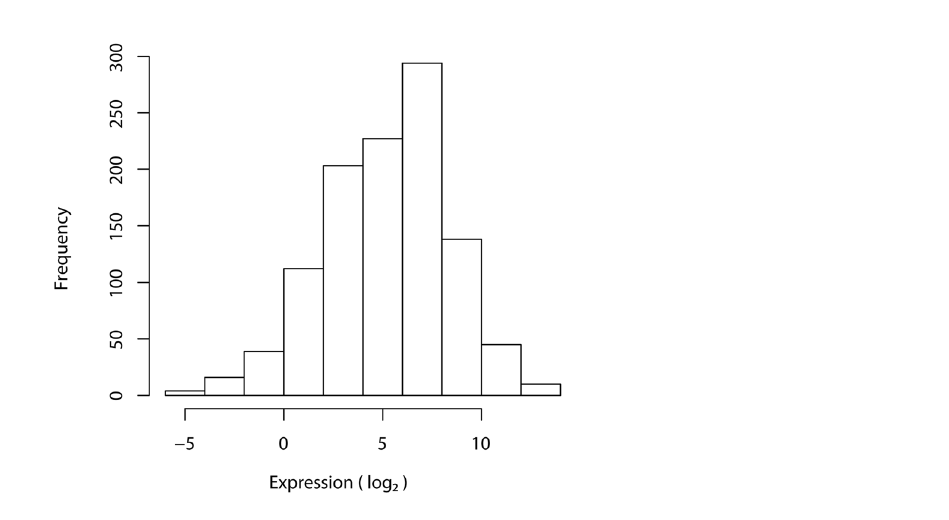
Figure 3. Expression distribution of detectable miRNAs from double positive replicates. Real-time qPCR was carried out on duplicate miRQC samples. Double positives are miRNAs detected in both duplicates. 131 double positives out of 164 total miRNA candidates were detected after applying the detection cut-off (Cq < 34). Expression range of the double positives is 18.64 log2-units, showing the system’s ability to detect a wide range of template concentrations.